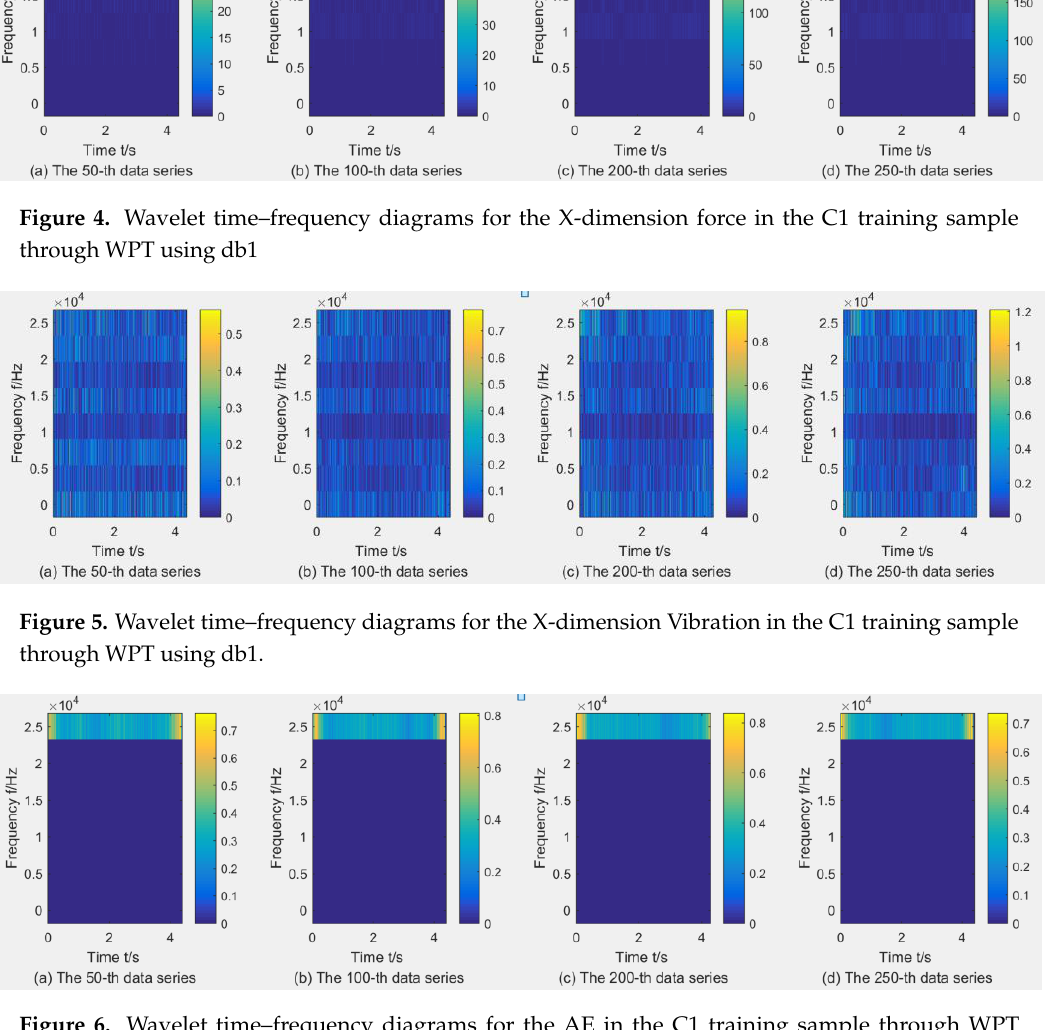
Figure 6. Wavelet time–frequency diagrams for the AE in the C1 training sample through WPT using